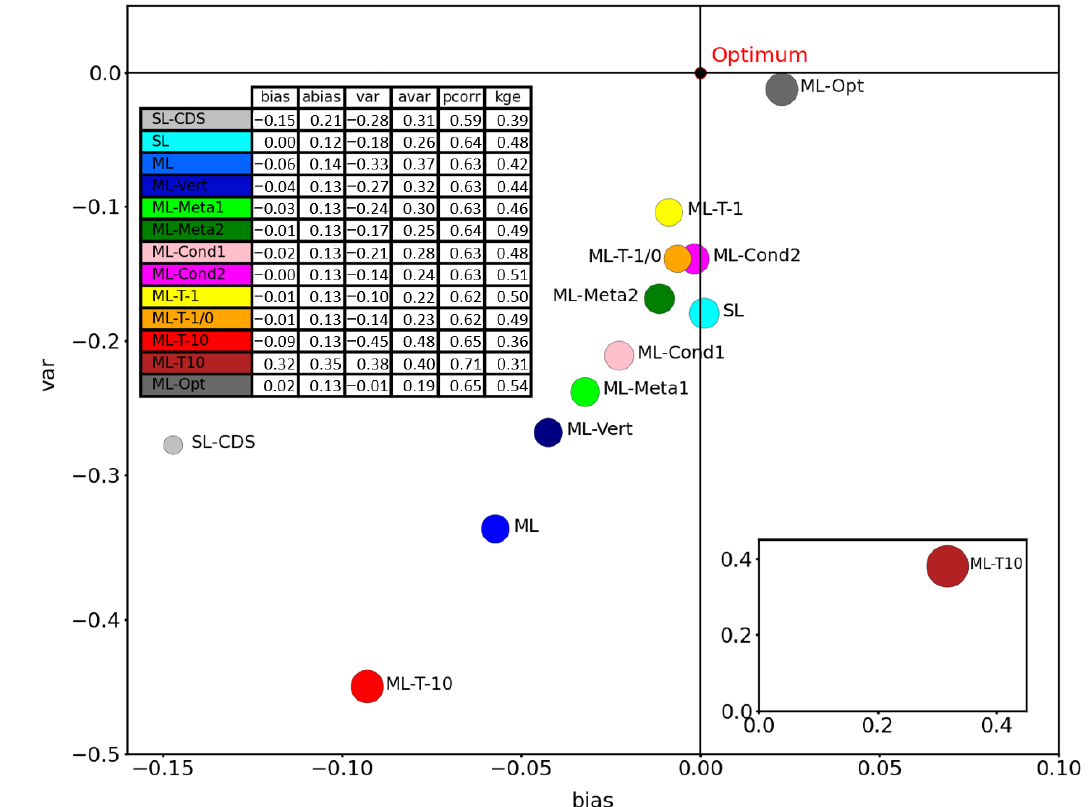
Figure 6. Scatter plot of area average scores for the 13 analyzed experiments. The scores are computed from 69 catchments in the 60 – 80 N belt of the permafrost (see Figure 1 for the area). The size of the dots represents pcorr . The outlier ML-T10 is displayed in an inset graph for better readability. The area average score values are provided for all analyzed experiments in the inset table.